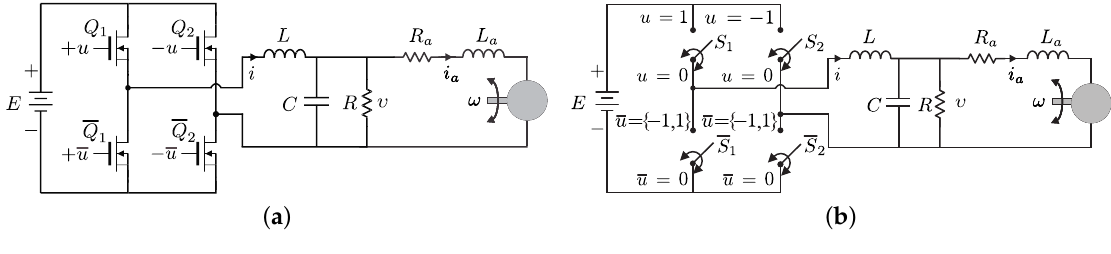
Figure 1. The full-bridge Buck inverter–DC motor topology: ( a ) proposed structure and ( b ) ideal configuration.